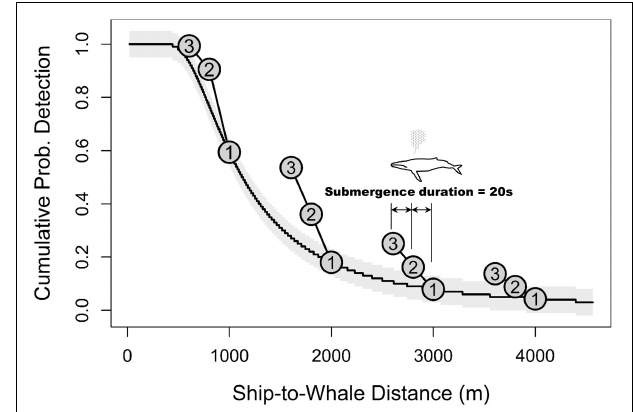
FIGURE 4 | The cumulative probability of detecting at least one of the three surfacing events for 3-event surfacing intervals that began with an initial surfacing event at 4000, 3000, 2000, or 1000 m from a ship. Circles represent the surfacing event number. The detection function used for calculating cumulative probabilities were from Williams et al. (2016) based on excellent sighting